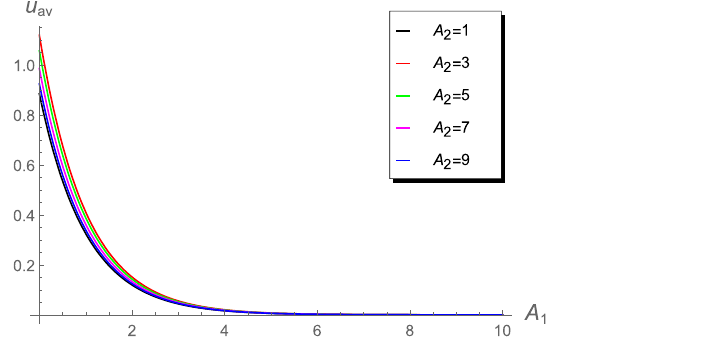
Figure 7. The u av against A 1 at different values of A 2 , A 0